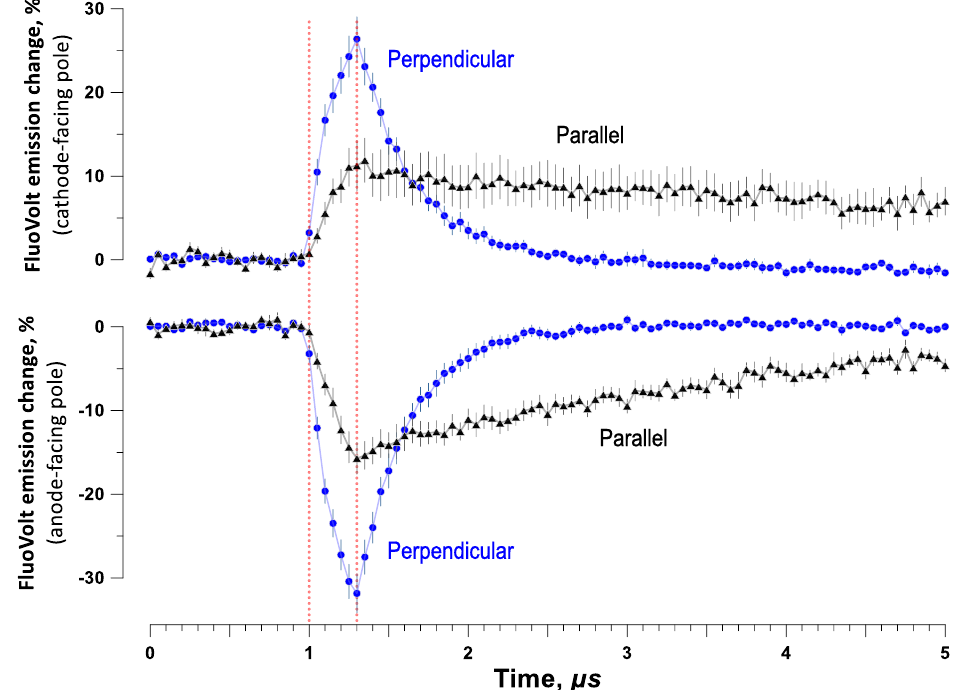
Figure 6. Membrane charging by a 300 ns, 0.3 kV/cm pulse is less efficient in smooth muscle cells aligned parallel with the electric field. The time course of the induced membrane potential was measured by strobe photography with a voltage sensitive FluoVolt dye and expressed as a percent change in the dye emission (mean ± SEM, n = 7). Vertical dotted lines denote the time when the pulse was applied. See text for more details.